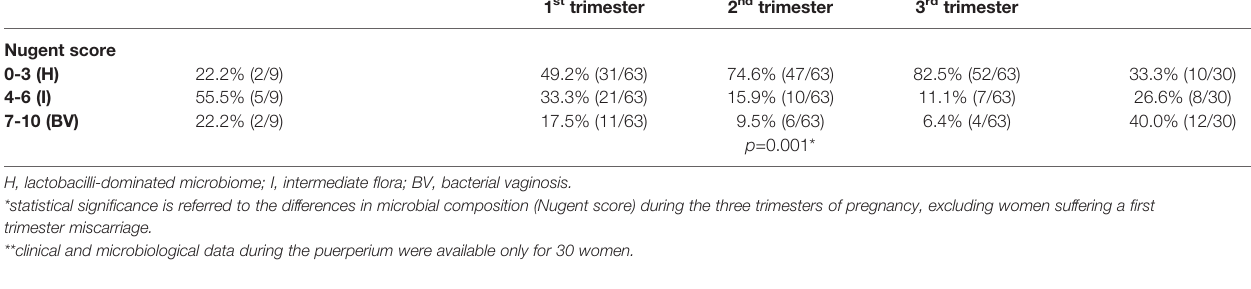
TABLE 1 | Characteristics of the vaginal environment (Nugent score), strati fi ed by the different gestation periods and conditions. First trimester miscarriage (n=9) Normal pregnancies